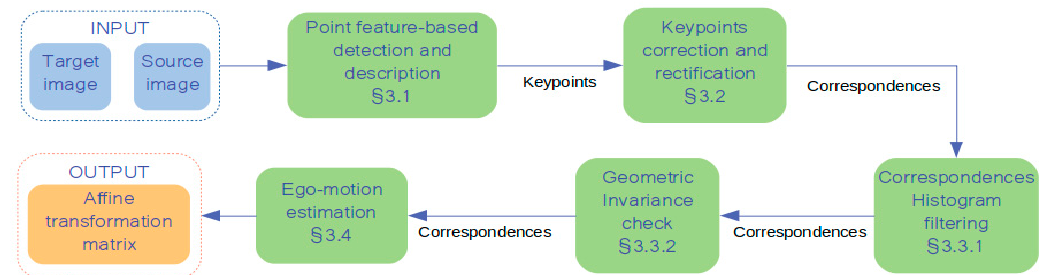
Figure 2. Processing pipeline employed in the methodology, starting from pair of successive images and providing the affine transformation matrix of the detected motion.